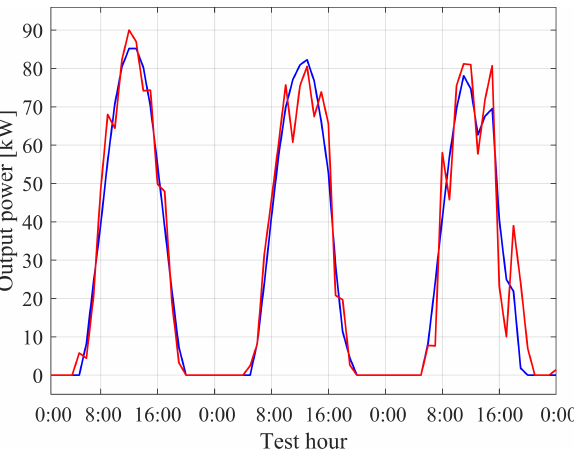
Figure 4. Predicted (red) and real (blue) value of output power in the mid of June 2018 by using the 2D-CNN approach with { S 1 , S 5 } as the best combination on 3-day test set (see Table 5, row 5, column